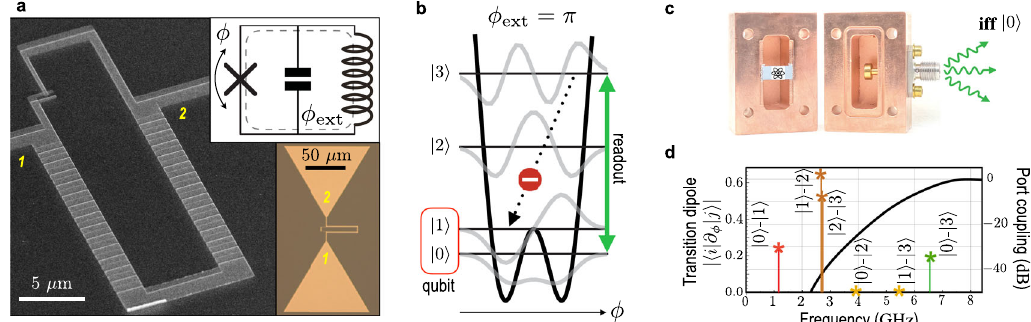
Fig. 1 Cavityless cQED with fl uxonium qubits. a Electron microscope image of fl uxonium ’ s superconducting loop, made of one smaller-area Josephson junction and an array of larger-area junctions. Top inset: fl uxonium ’ s effective three elements circuit model. Bottom inset: the smaller-area junction is connected to bow-tie antenna capacitance (optical image). b Effective potential seen by the phase-difference ϕ across the smaller-area junction (black), energy levels (horizontal black lines), and wavefunctions (gray) at the half-integer external fl ux through the loop, ϕ ext = π . The qubit levels are 0 j i and 1 j i , the readout transition is 0 j i (cid:2) 3 j i , and even transitions are dipole-forbidden. c Setup for a broadband wireless coupling of fl uxonium circuit to an external coaxial cable (not shown). d Transition frequencies and corresponding matrix elements of the Cooper pair number operator − i ∂ ϕ (colored stars). The solid line shows microwave transmission through the enclosure measured using a symmetric two-port con fi guration. Single-port con fi guration is used for all other measurements, as shown in Fig.